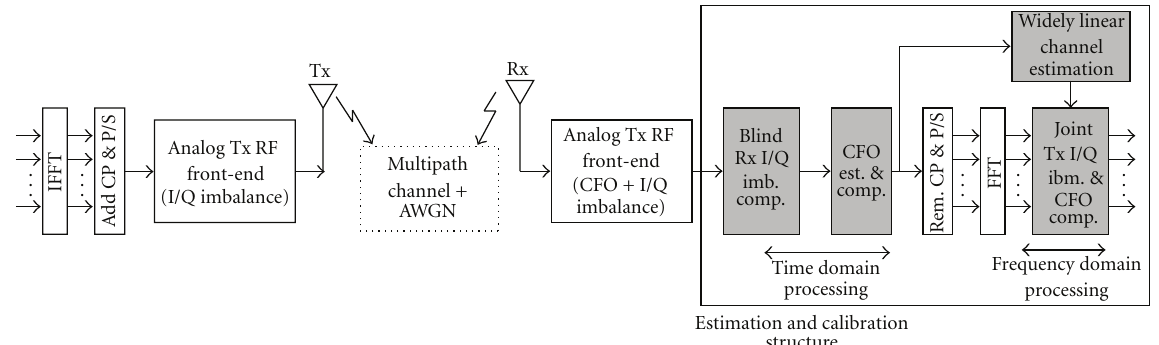
Figure 4: OFDM system model with preamble pilot compensator